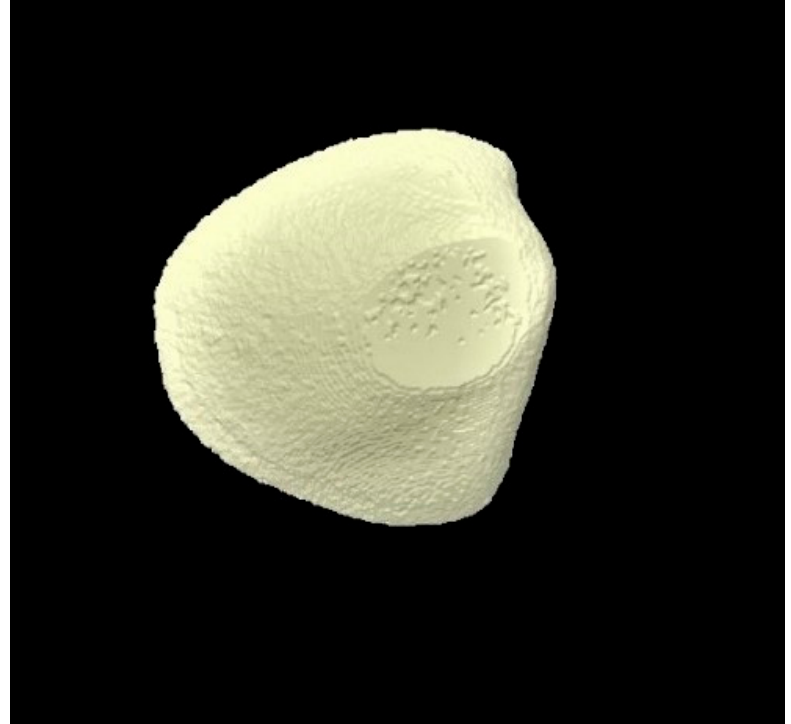
Figure 7. Micro-CT image of group 2 samples presenting enamel surface post-remineralization.